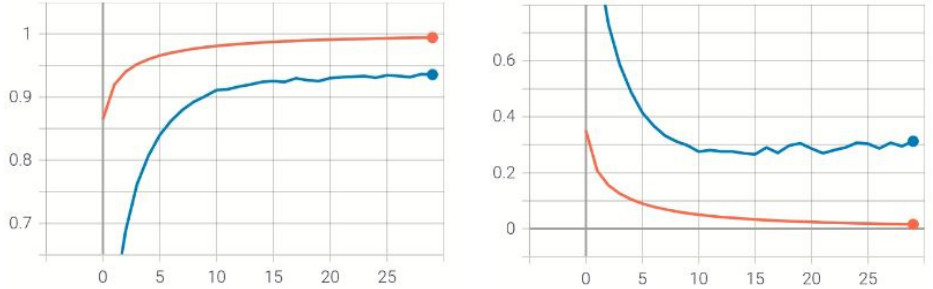
Figure 7. The training output of classifier network on the DFDC dataset. The accuracy of the model is on the left, while the loss of the model is on the right. The red represents the training outcomes, while the blue represents the validation outcomes. Table 2. Training results of the classifier network on validation set of Celeb-DF v2 and